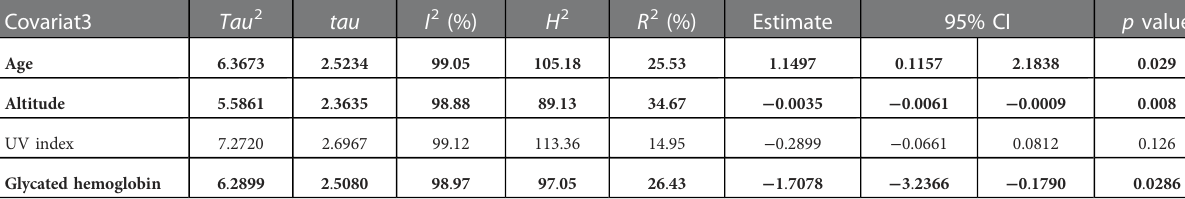
TABLE 3 Univariate meta-regression analysis of intrinsic and extrinsic determinants for tOC in T1D. Covariat3 Tau 2 tau I 2 (%) H 2 R 2 (%) Estimate 95% CI p value Age 6 . 3673